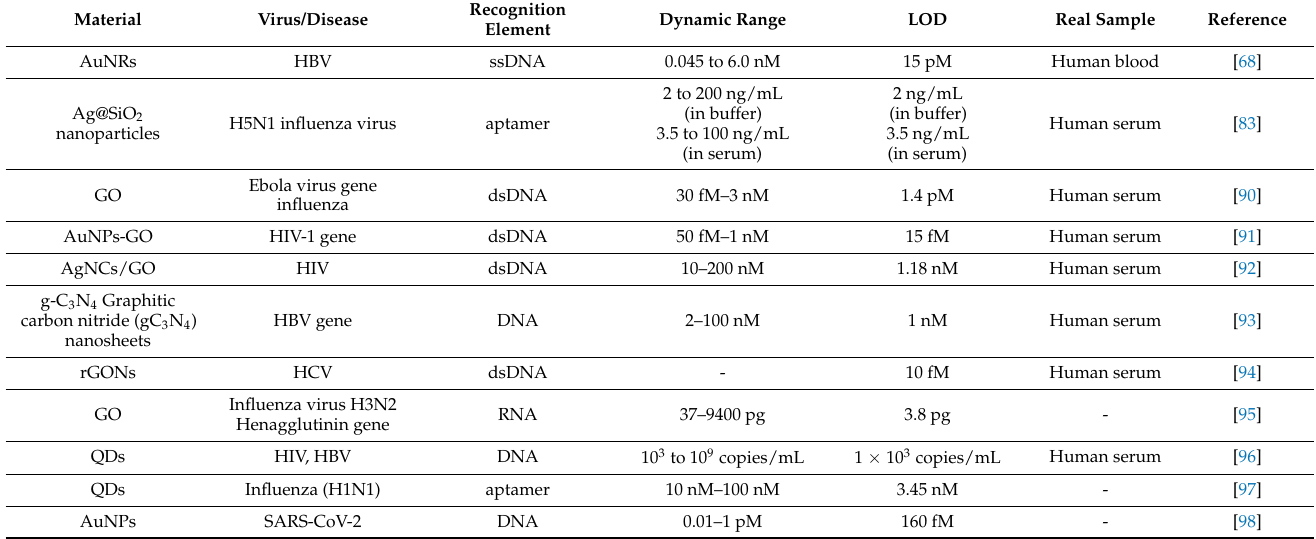
Table 2. List of the fluorescent biosensors for virus